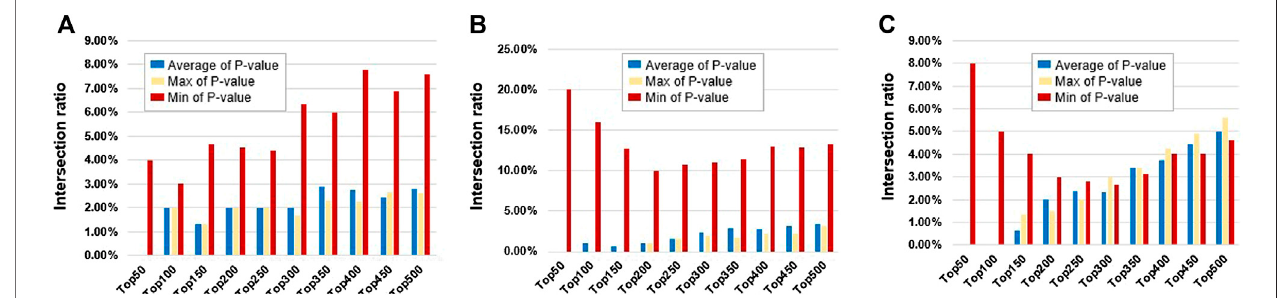
FIGURE 3 | Intersection ratios of top N differential genes derived from different probes between different datasets (between the average, max, and min p -value of probes). The blue bars represent top N genes derived from the average p -value of probes, the yellow bars represent top N genes derived from max p -value of probes, and the red bars represent top N genes derived from min p -value of probes. (A) Between GSE50660 and GSE53045 dataset. (B) Between GSE50660 and GSE85210 dataset. (C) Between GSE53045 and GSE85210 dataset.